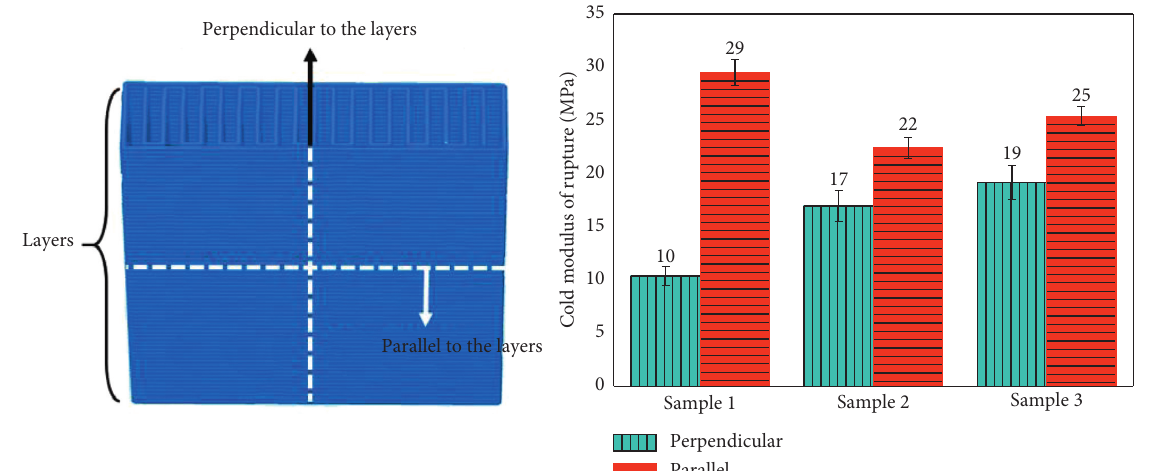
Figure 6: Cold modulus of rupture in different directions of samples: (1) vertical supporting structure, (2) oblique square grid supporting structure, and (3) honeycomb grid supporting